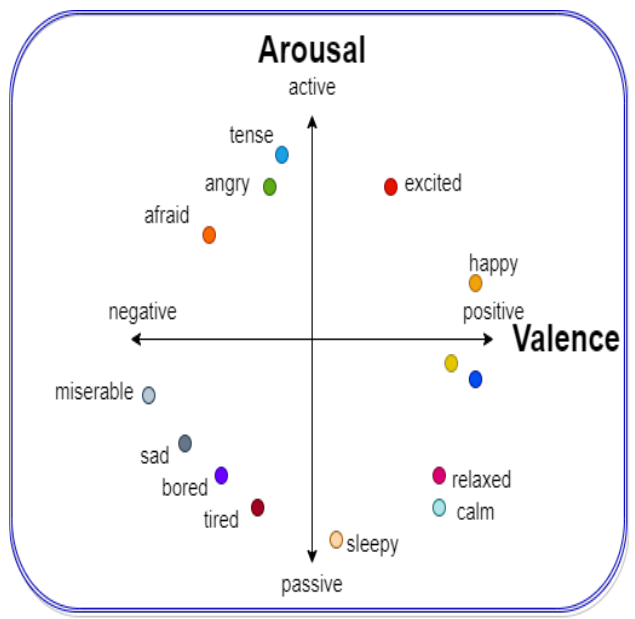
Figure 1. Valence arousal model